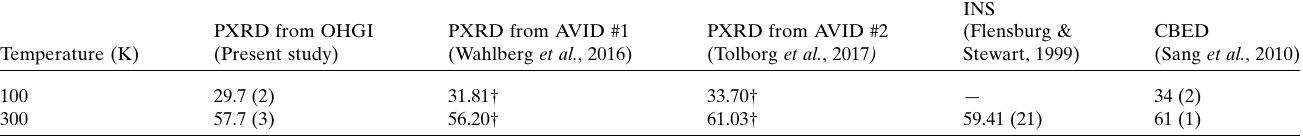
Table 1 Comparisons of the ADPs of Si between the present study and previous reports. All the values in the table are shown in units of 10 (cid:2) 4 A˚ 2 , unless stated otherwise. INS and CBED stand for inelastic neutron scattering and convergent-beam electron diffraction, respectively.